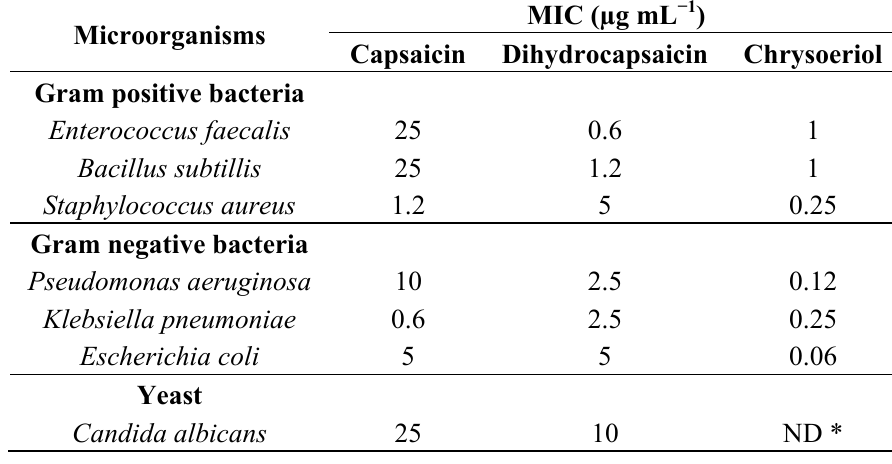
Table 3. Minimal inhibitory concentration (MIC) of capsaicin, dihydrocapsaicin and chrysoeriol to seven